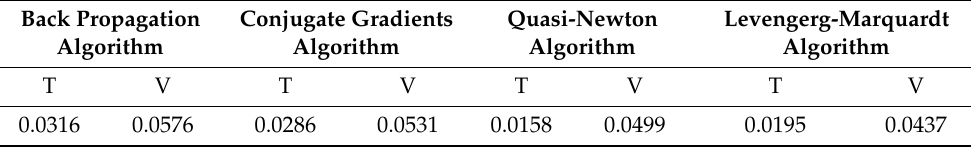
Figure 23. Multilayer ANN 5:5-8-1:1.